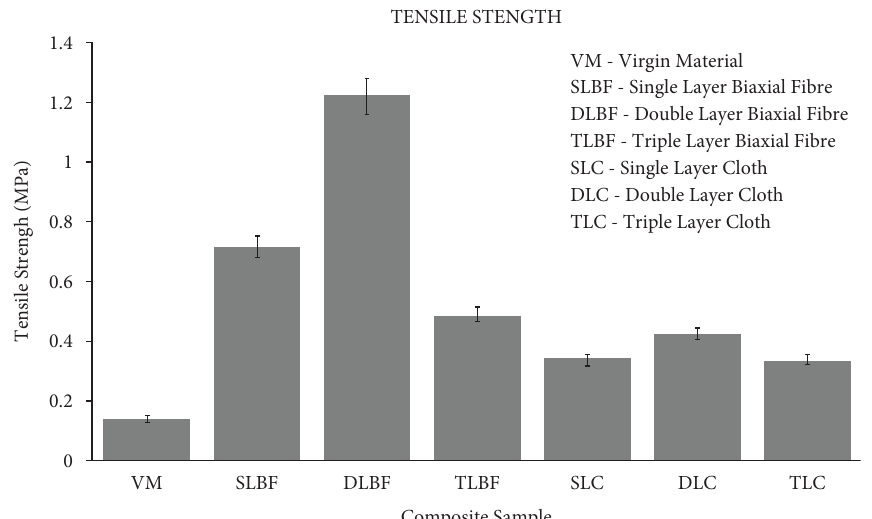
Figure 12: Comparative study of tensile strength of SFs and SCs reinforced vinyl ester composites.